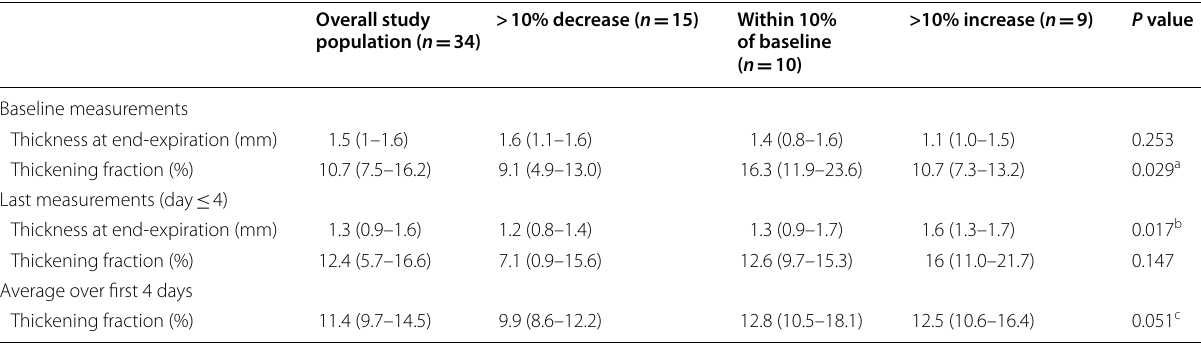
Table 2 Diaphragm thickness and thickening fraction based on changes in thickness in first 4 days of